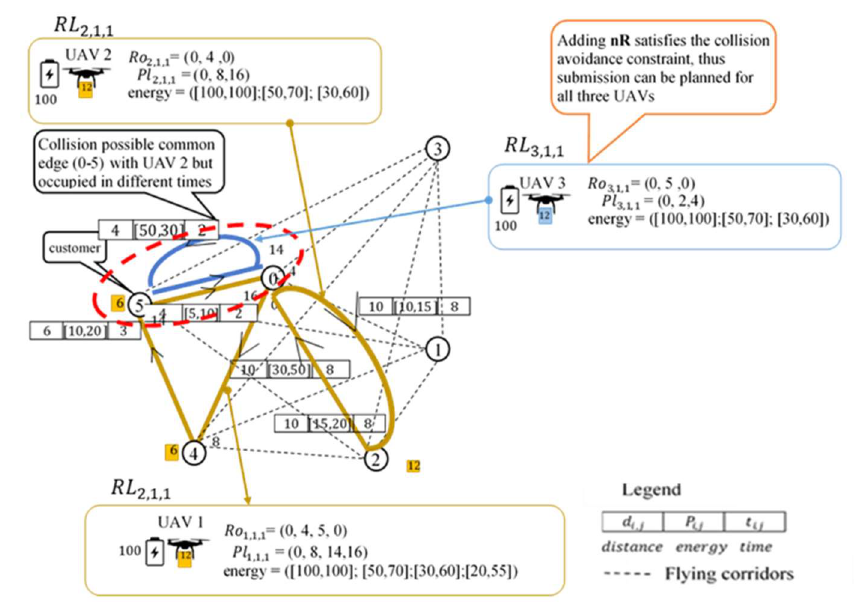
Figure 12. An illustration showing that adding nR satisfies the collision avoidance constraint.